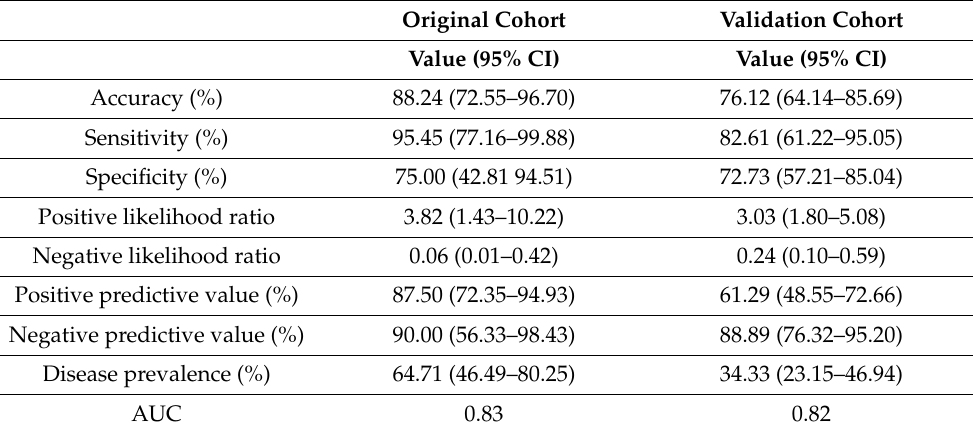
Table 2. Summary of classification results obtained for the original and the validation cohort. CI: con- fidence interval; AUC: area under the